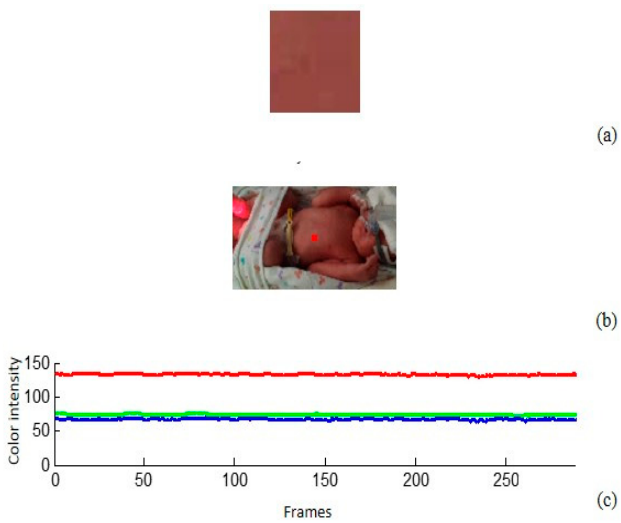
Figure 4. Capture of the plethysmographic signal processing with Matlab, ( a ) region of interest (ROI), ( b ) image analysis, and ( c ) graph average signals of the RGB-channels.